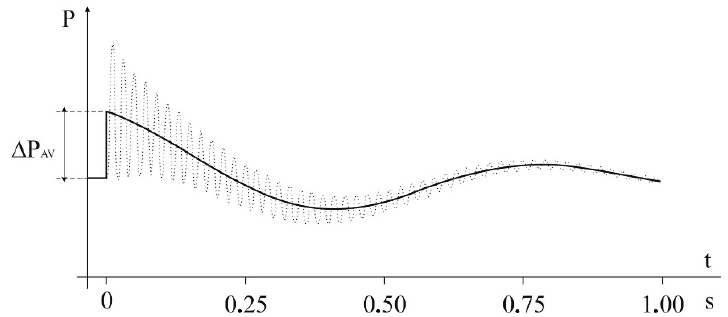
Figure 1. Oscillations of the output power of the synchronous generator caused by switch-on operation—interpretation of ∆ P G i _AV